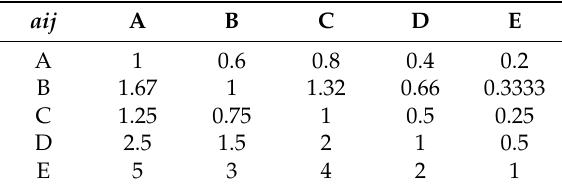
Table 5. Judgment matrix for area